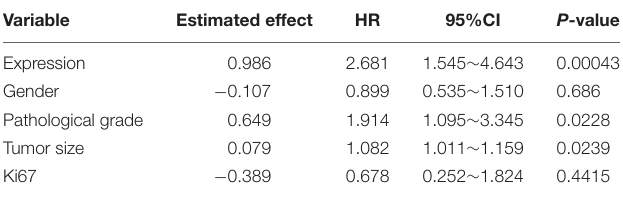
TABLE 1 | Clinicopathological characteristics GC patients in purchased microarray.